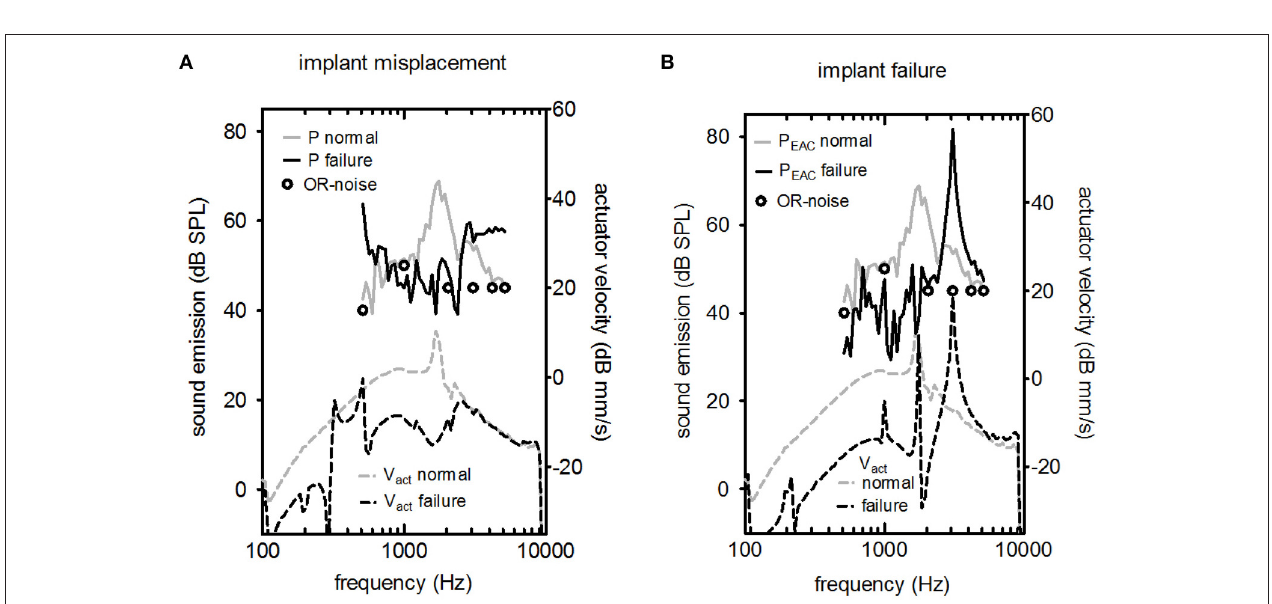
FIGURE 5 | LDV (Laser Doppler velocity) measurement of V act (upper part) and the resulting sound pressure in the ear canal P EAC (lower part) for two cases of failure (excitation level 316 mV). (A) The actuator’s vibrating rod was in contact with the surrounding bone, and (B) the actuator had a non-standard response. In both graphs, the typical background noise in an operating room (OR) during hearing implant surgery is shown (circle symbols). Figure 4B shows the averaged V act and P EAC for five cadaver piston prosthesis, V act and P EAC were reduced. Compared heads. LDV measurements provided stable and reproducible to P EAC measurement, the LDV data showed a smoother results within the entire frequency range (100–10,000 Hz). response.